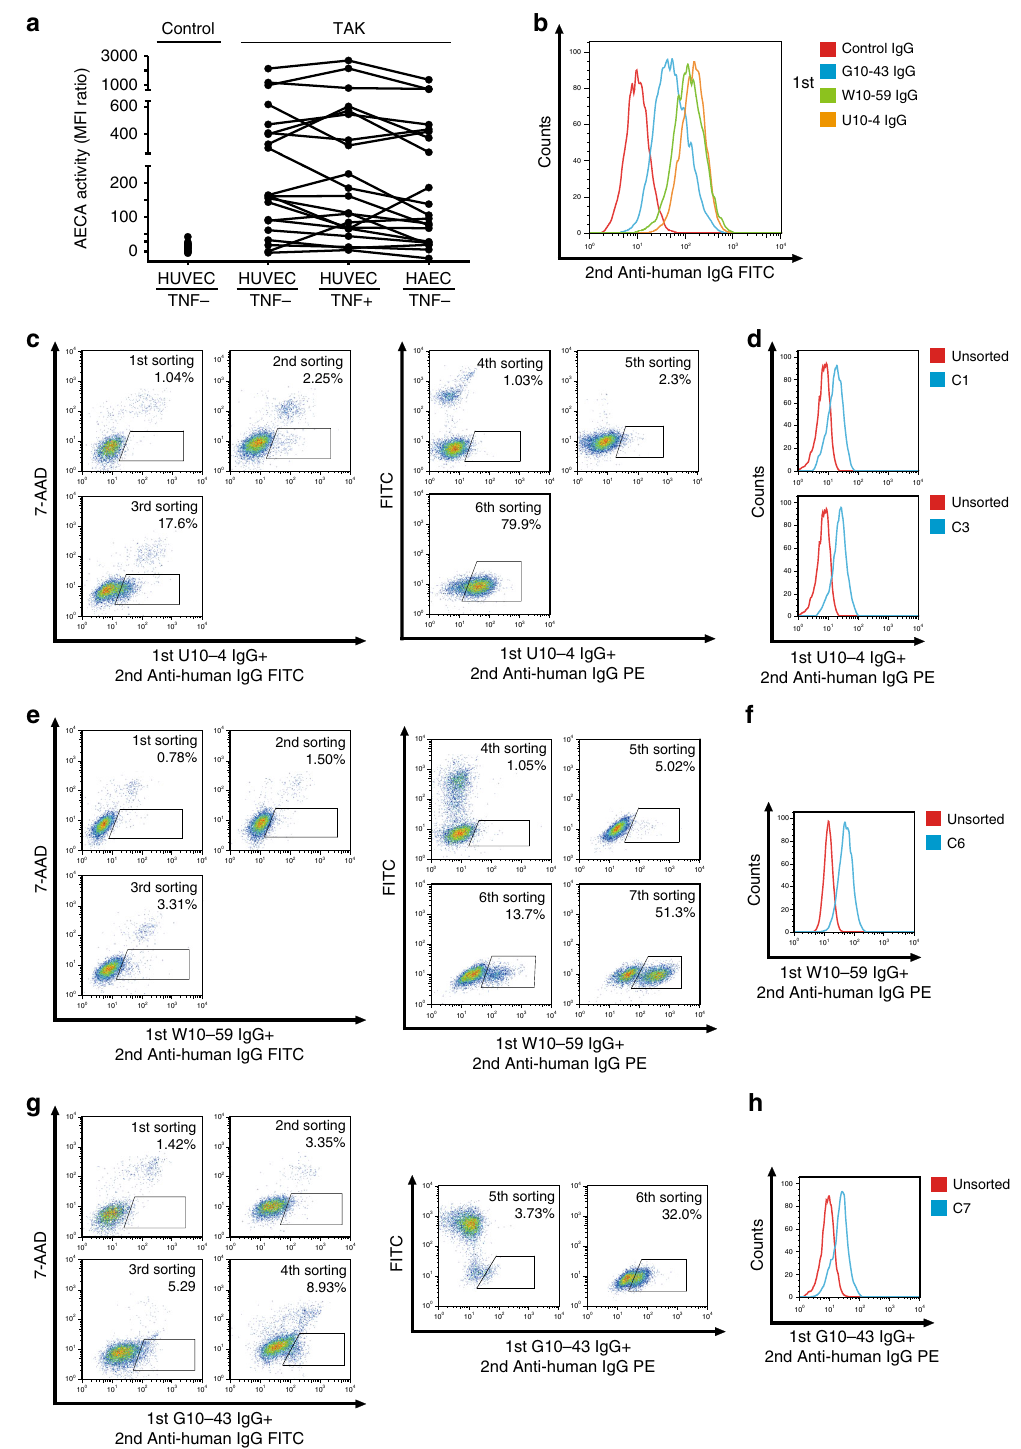
Fig. 1 Subcloning of autoantigen-expressing cells by using IgG from patients with Takayasu arteritis. a AECA activity against HAECs or HUVECs treated with or without 1 ng/mL TNF- α for 6 h was measured with fl ow cytometry in patients with Takayasu arteritis (TAK, n = 21). Dots represent the data for individual subjects. Dots connected with lines indicate the same patients. Control indicates healthy individuals ( n = 79). b Nonpermeabilized HUVECs were stained with 0.5 mg/mL puri fi ed IgG obtained from a healthy individual or patients with TAK, followed by incubation with secondary antibody and fl ow cytometry analysis. c – h Sorting of cells expressing cell-surface autoantigens by using three different AECAs. c , e , g YB2/0 cells expressing HUVEC cDNA were stained with 0.5 mg/mL U10-4 IgG ( c ), W10-59 IgG ( e ), or G10-43 IgG ( g ), followed by incubation with secondary antibody, and cells in the positive fraction (squares) were sorted by fl ow cytometry. FITC-conjugated IgG antibody was initially used, and PE-conjugated IgG antibody was subsequently used as a secondary antibody. d , f , h Binding activity of serum IgG to unsorted cells or cloned cells from sorted cells (C1 [upper] and C3 [lower] isolated from U10-4, D; C6 isolated from W10-59, F; C7 isolated from G10-43, H, respectively); cells were stained with 0.5 mg/mL prototype AECA IgG, followed by incubation with secondary antibody and fl ow cytometry analysis. G10-43, W10-59, and U10-4 indicate the serum sample number. NATURE COMMUNICATIONS| (2020) 11:1253 |https://doi.org/10.1038/s41467-020-15088-0|www.nature.com/naturecommunications